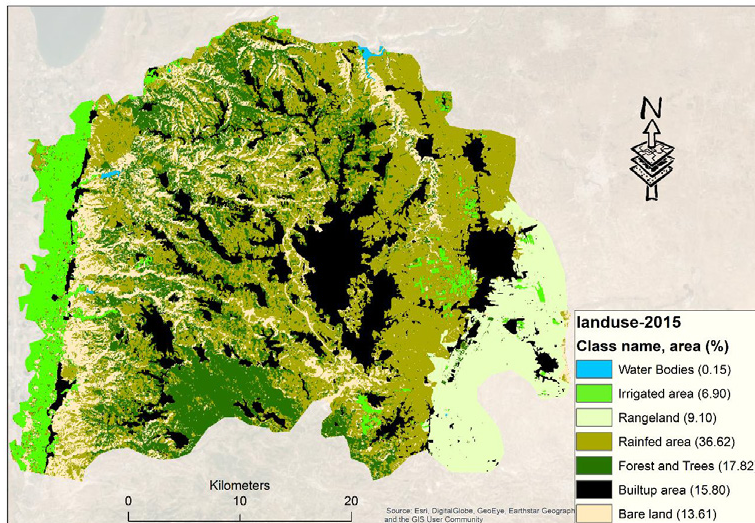
Fig. 3d: Land use in Irbid governorate in 2015